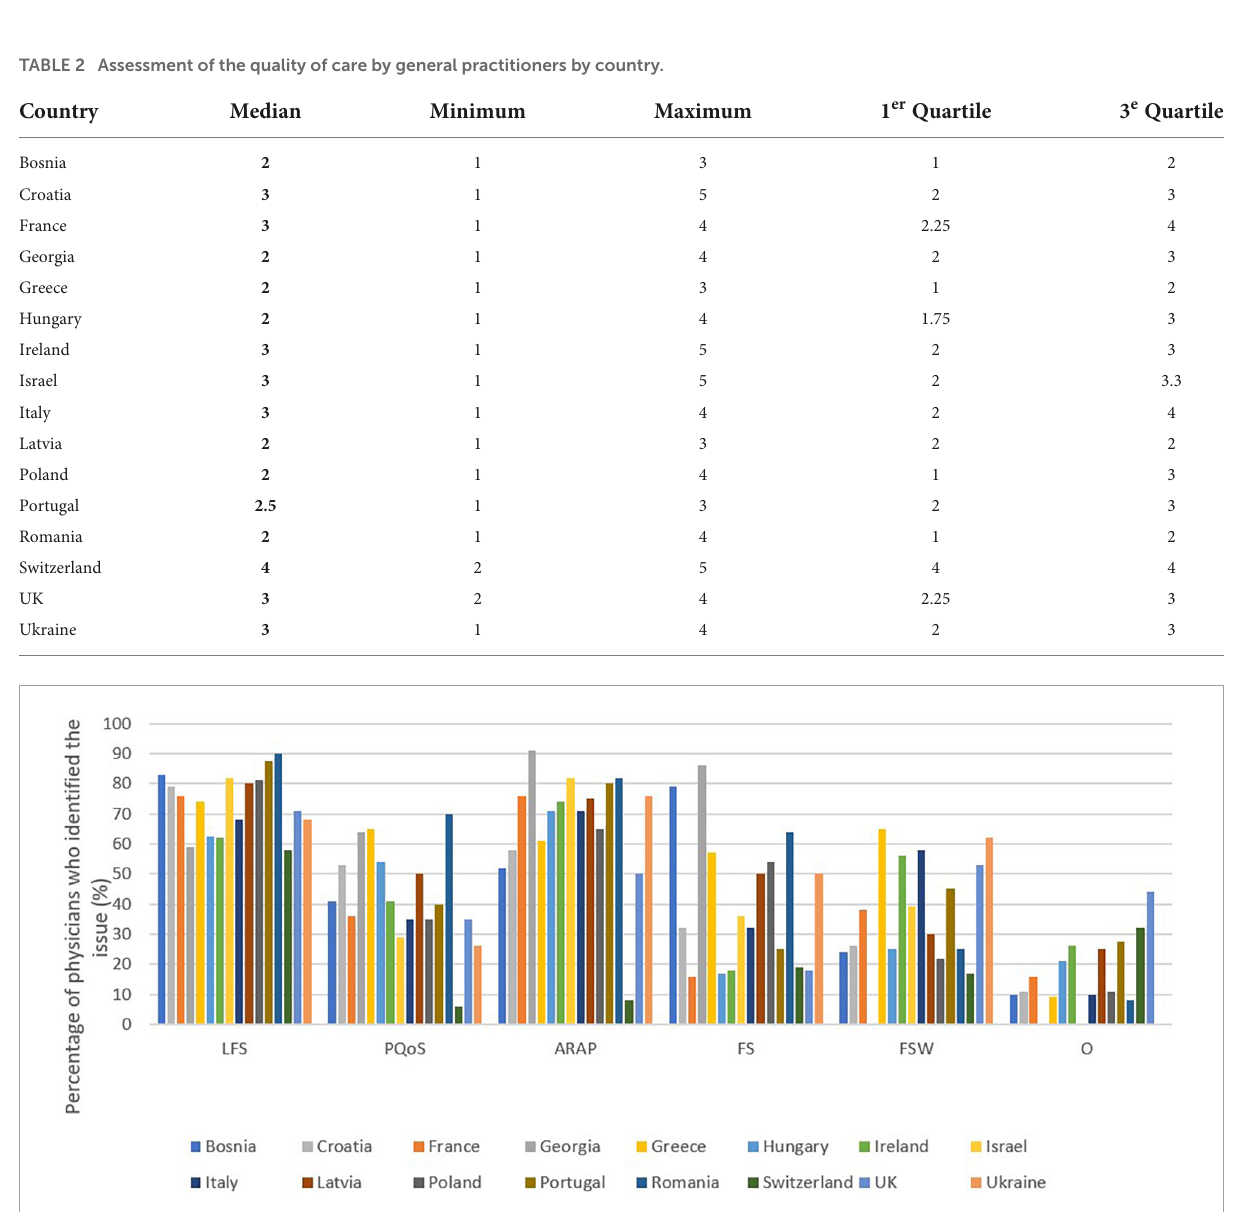
FIGURE8 Main issues with intermediate care. LFS, Limited financial support; PQoS, Poor quality of service; ARAP, Access difficulties with restrictive administrative procedures; FS, A stigma for the family (for the retirement home); FSW, A feeling that the situation is worsening in recent years, due to cuts in health spending; O,